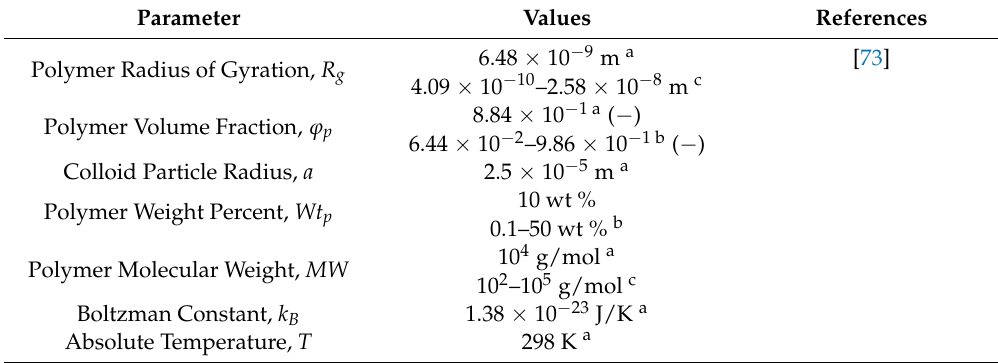
Table 3. Parameter values of depletion interaction employed in the theoretical